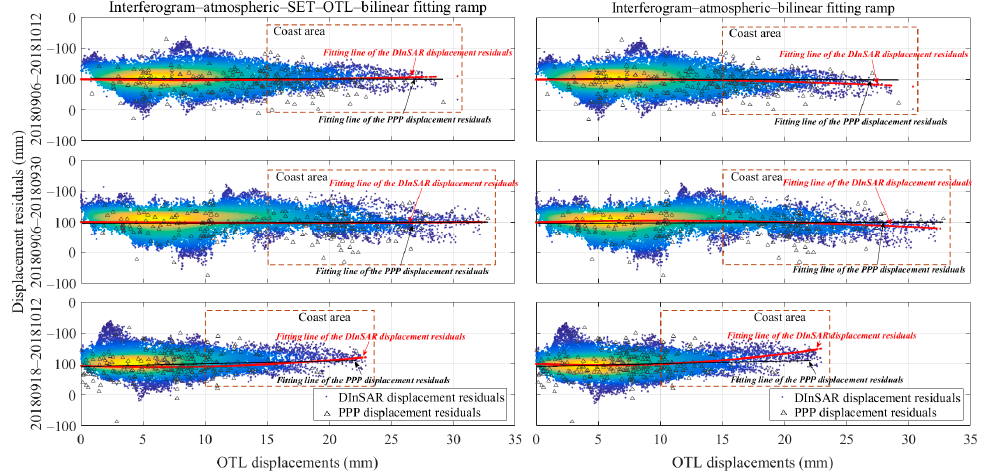
Figure 9. The comparison of the displacement residuals in the long-strip differential interferograms after the OTL and SET displacements corrected using the proposed tidal method (interferograms- atmospheric-SET-OTL-bilinear fitting ramp) and traditional bilinear ramp fitting method (interfer- ograms-atmospheric-bilinear fitting ramp). To further compare and analyse the OTL correction difference between the proposed method and the FES2014b+osu.usawest model, the coastal area A with a larger OTL dis- placement difference in Figure 4 was selected to validate the improvement of the pro- posed tidal method. As the results are shown in Figure 10, the absolute value of the fitting line slope of the proposed OTL calculation method is smaller than that of the tidal model in the interferograms 20180906–20181012 and 20180918–20181012, so the tendency of the OTL displacement can be effectively eliminated that suggests the OTL correction im- provement of the proposed tidal method in complex coastline areas.